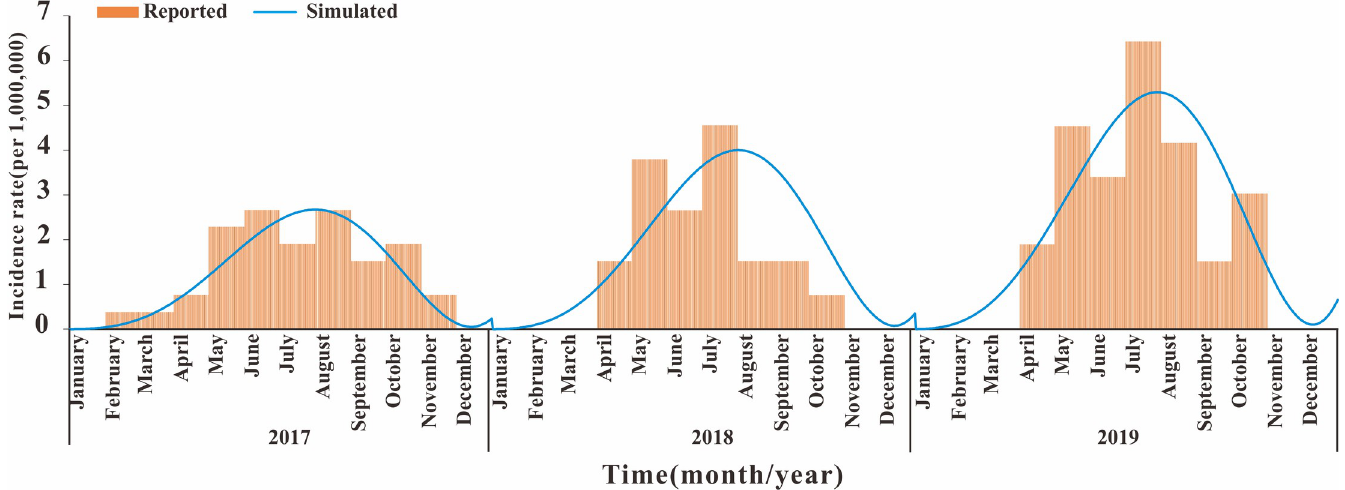
Fig 3. MMDM fitting result of SFTS incidence of 2017–2019. MMDM: Multi-population and multi-route dynamic model of SFTS.